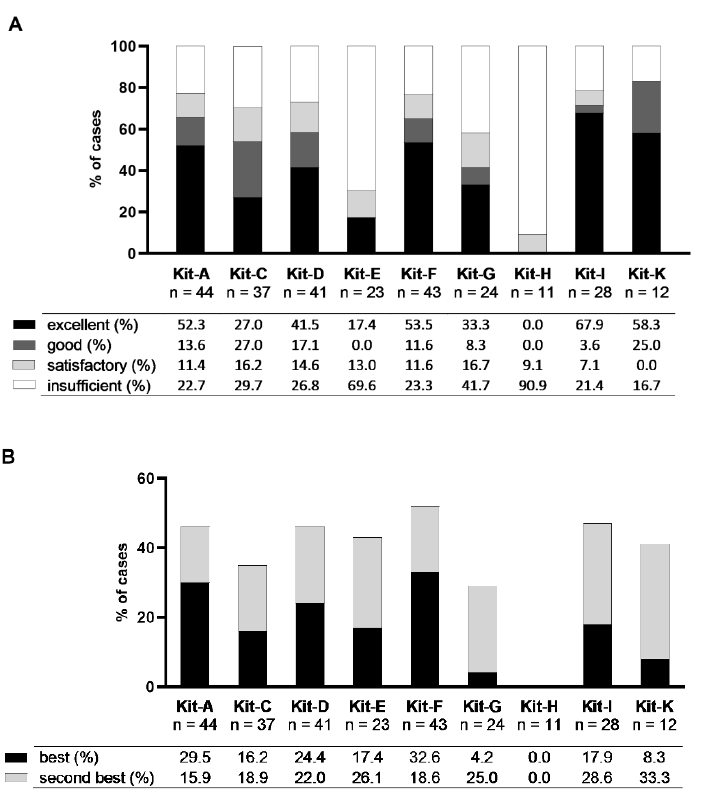
Figure 5. Class- and best-ranking of Kit-A, -C, -D, -E, -F, -G, -H, -I and -K. Given are ( A ) the class- ranking with the proportions of cases with sufficient (excellent, good, satisfactory) and insufficient DC/DC leu -generation using kits and ( B ) the best-ranking with proportions of cases with best- and second-best DC/DC leu -generation using kits.